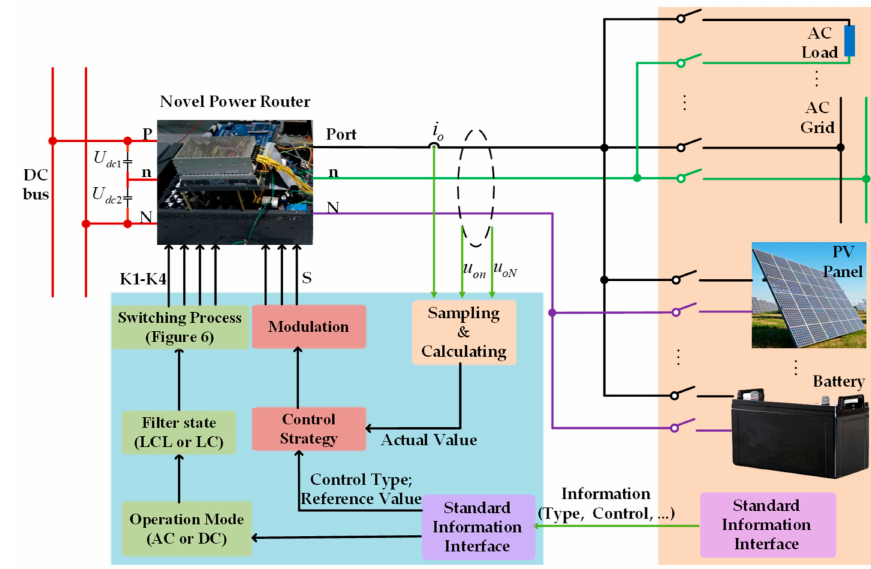
Figure 8. Control Structure of the Power